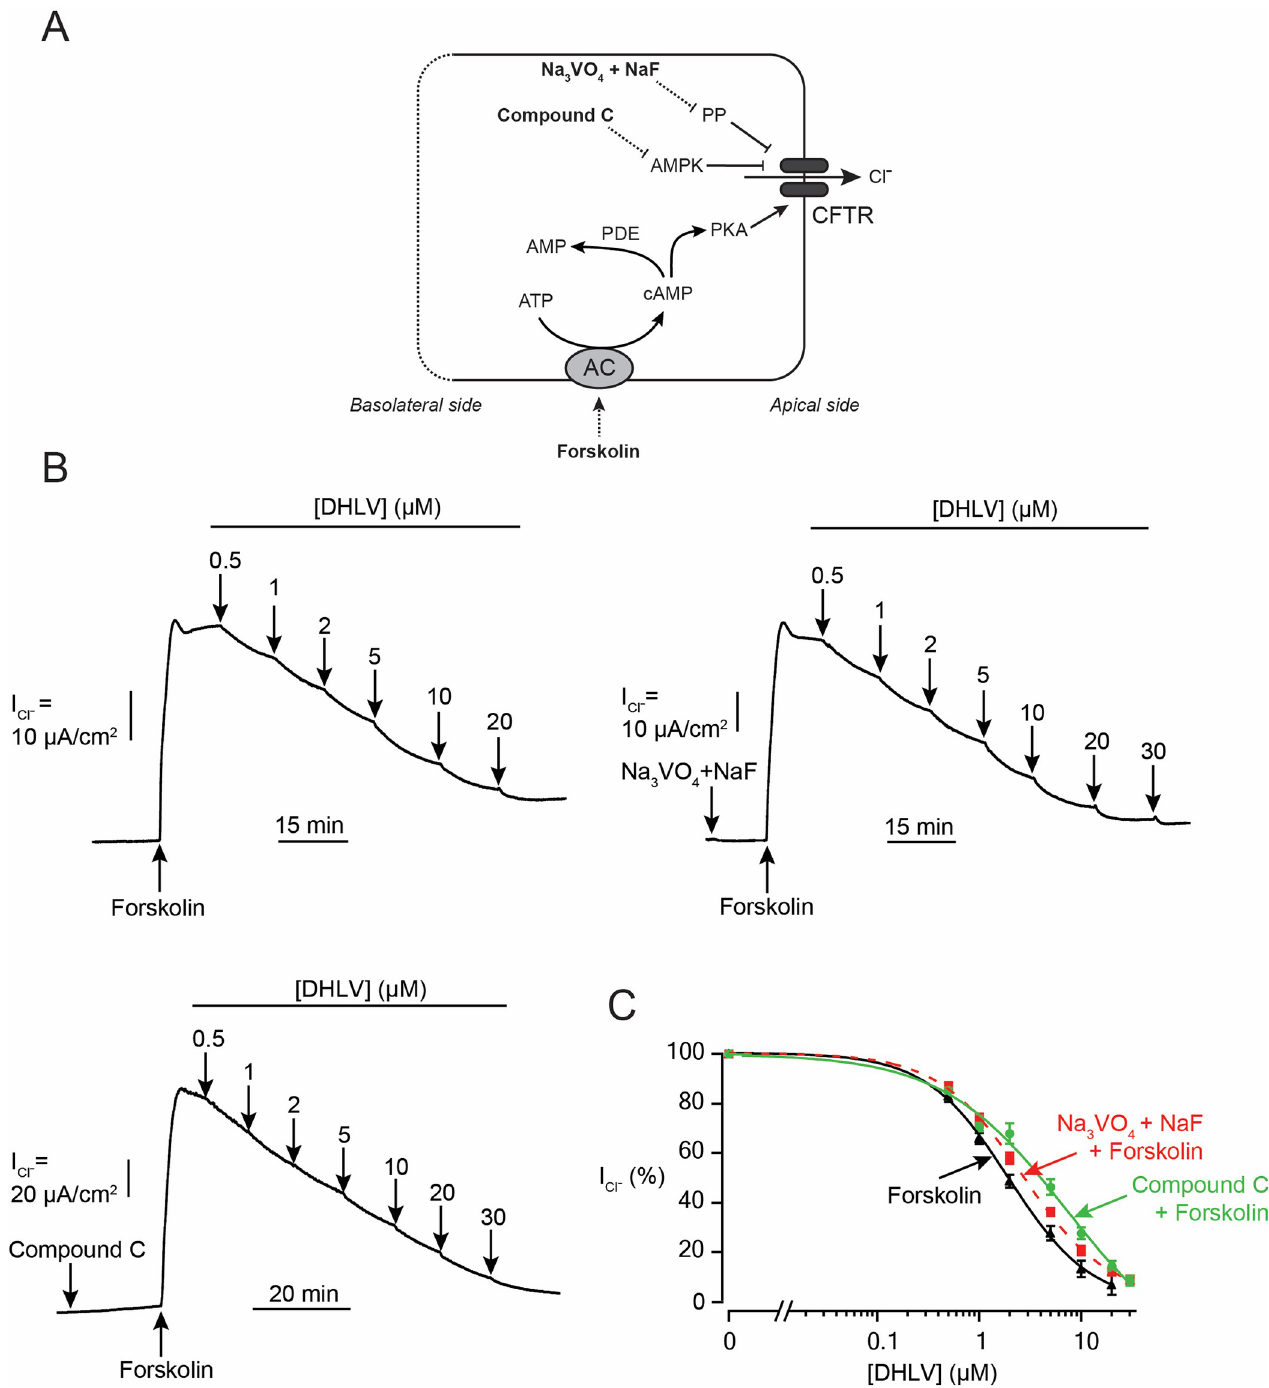
Fig 5. No involvement of CFTR negative regulators in CFTR inhibition by DHLV. (A) Schematic diagrams showing the regulatory mechanism of CFTR Cl - channel activity. (B) apical Cl - current (I Cl - ) tracing showing the effect of α , β -dehydrolovastatin (DHLV) on forskolin-induced CFTR Cl - secretion in T84 cells pre-treatment with compound C (50 μ M) or and NaF plus Na 3 VO 4 (1 mM) for 15 min. (C) Summary of concentration-inhibition studies. Data are fitted to Hill’s equation and expressed as means of % agonist-stimulated I Cl - ± S.E.M. ( n = 5–9).